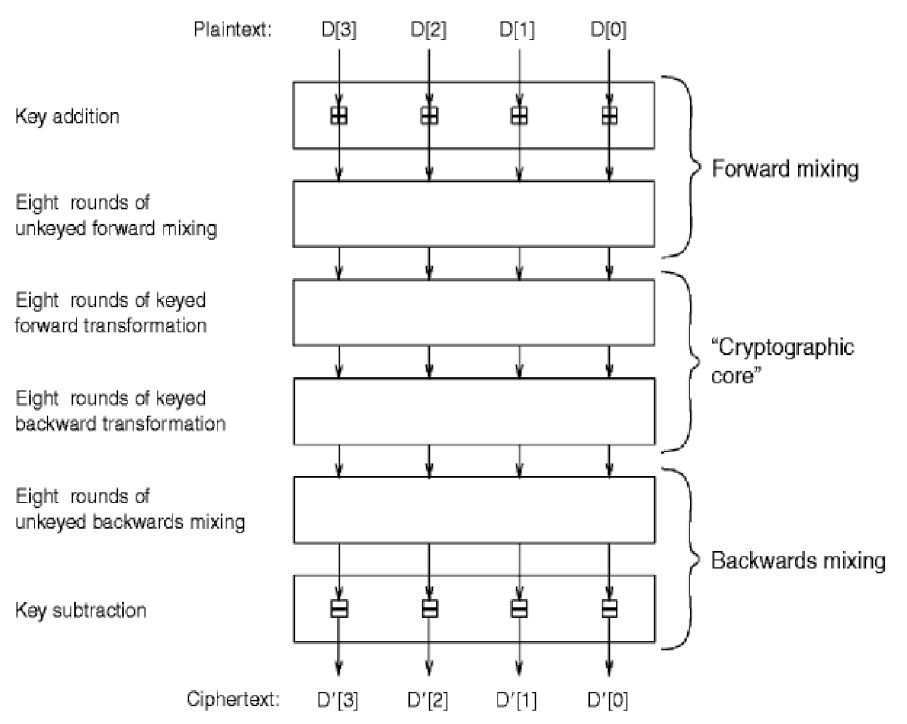
Figure 3. The cipher’s high-level structure.